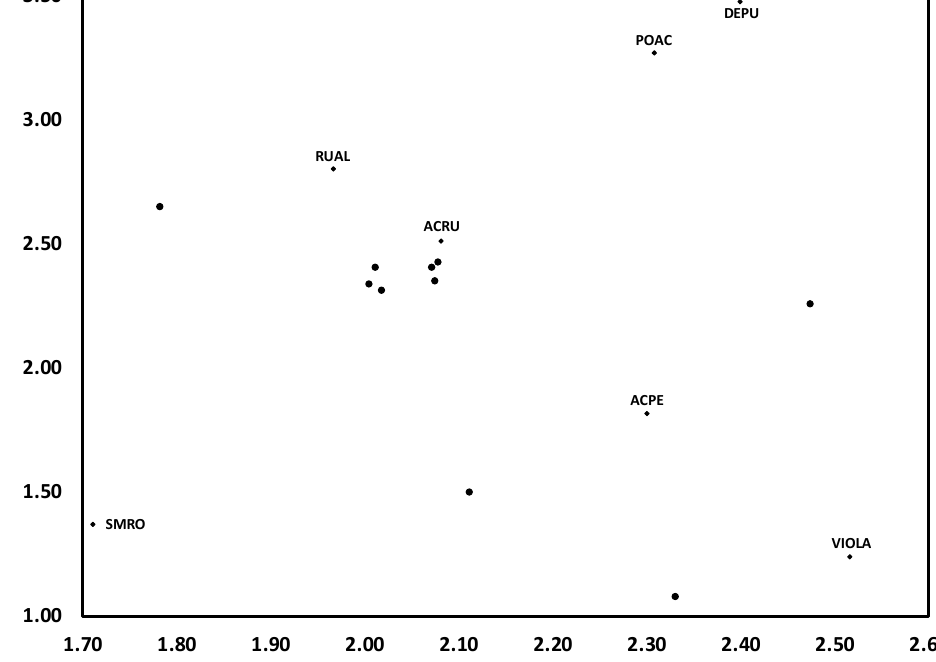
Figure 4. Detrended correspondence analysis (DCA) for herbaceous layer communities from 1991 to 2014 on N-treated WS3. Depicted are prominent species, along with centroids as shown in Figure 3. Species codes are as follows: ACPE ( Acer pensylvanicum ), ACRU ( A . rubrum ), DEPU (Dennstaedtia punctilobula), POAC( Polystichumacrostichoides ), RUAL( Rubusallegheniensis ), SMRO( Smilaxrotundifolia ), and VIOLA ( Viola